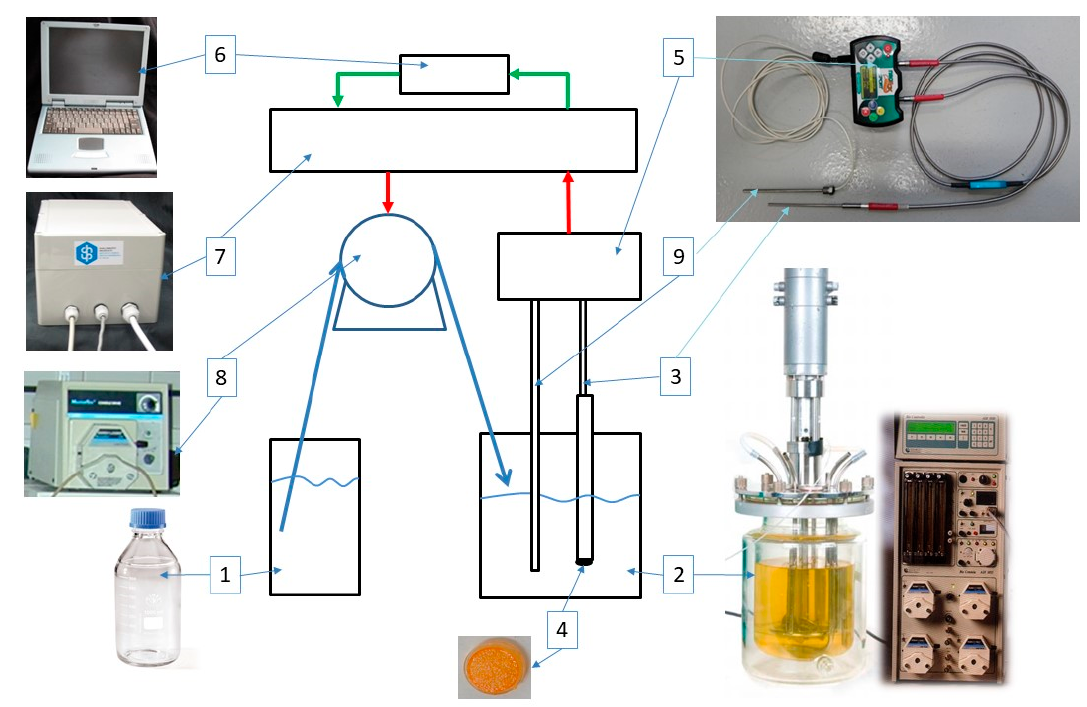
Figure 2. Feedback regulation system. 1. container with buffer or concentrated glucose solution, 2. bioreactor Applicon (5 L), 3. optical fibres, 4. lens with sensitive layer, 5. light source and the detector ( λ EX = 470 nm, λ EM = 580 nm), 6. PC LabView, 7. control unit, 8. peristaltic pump, 9. temperature probe of NeoFox.